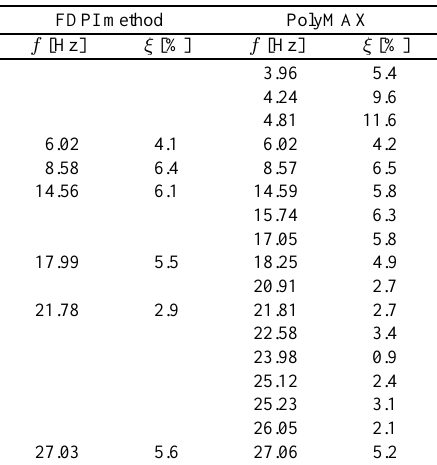
Table 1 Eigenfrequencies and damping ratios obtained by applying the FDPI and the PolyMAX